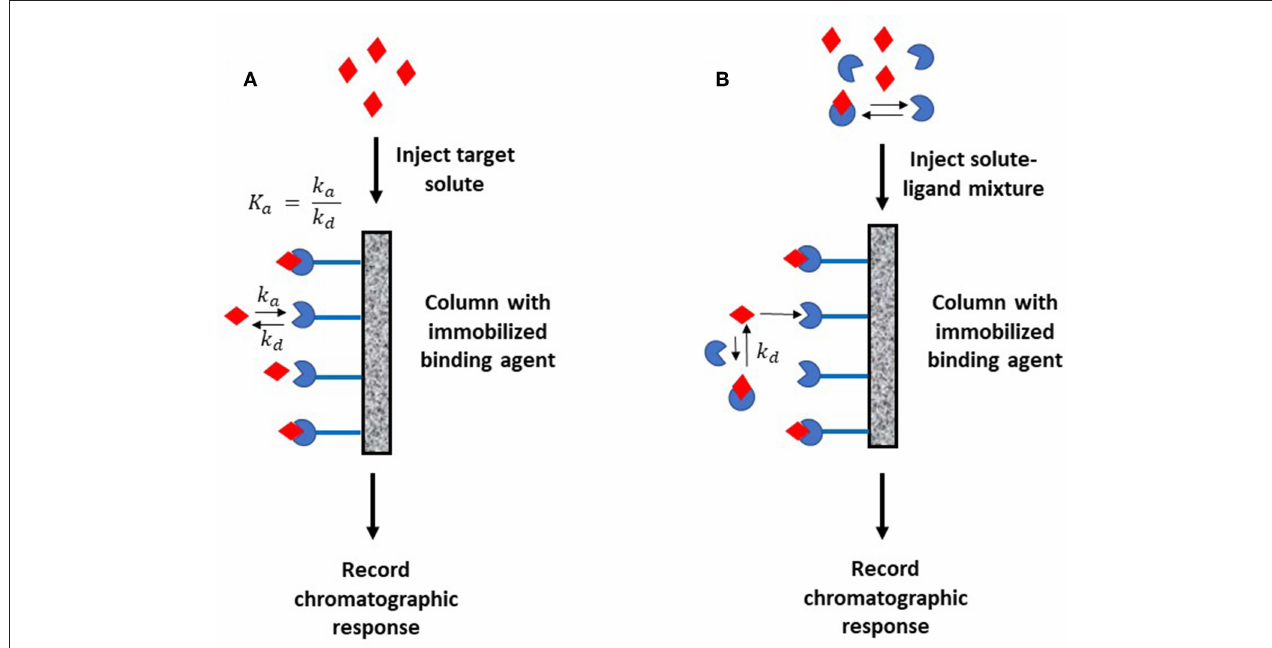
FIGURE 1 | Two general formats employed in affinity chromatography and HPAC for examining the kinetics of an analyte interaction with a binding agent. The method in (A) is based on the reversible interactions between the analyte and an immobilized binding agent, while (B) is based on the utilization of a secondary probe on the column to capture part of the analyte and monitor interactions of this analyte with a binding agent in solution. Terms: K a , association equilibrium constant; k a , association rate constant; k d , dissociation rate